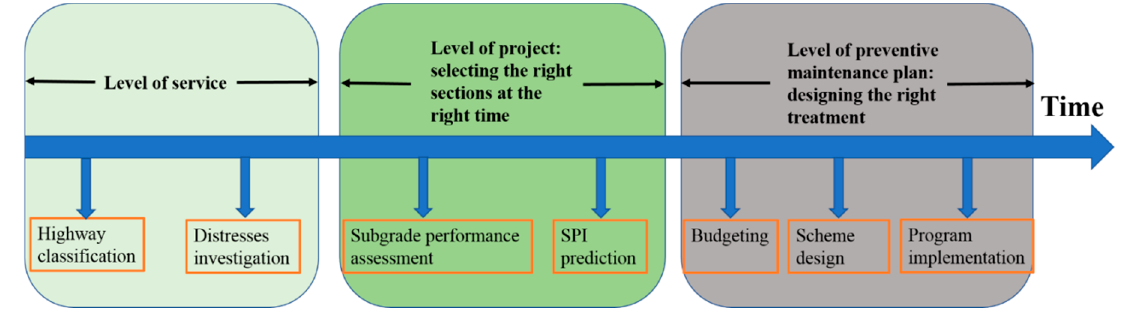
Figure 10. Life-cycle decision-making framework for preventive maintenance.